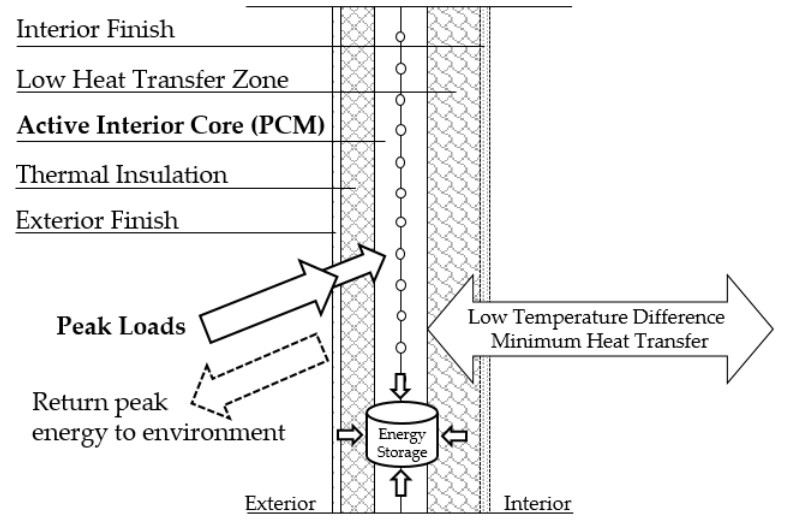
Figure 6. Constructive solution with enhanced PCM (adapted from [54]).